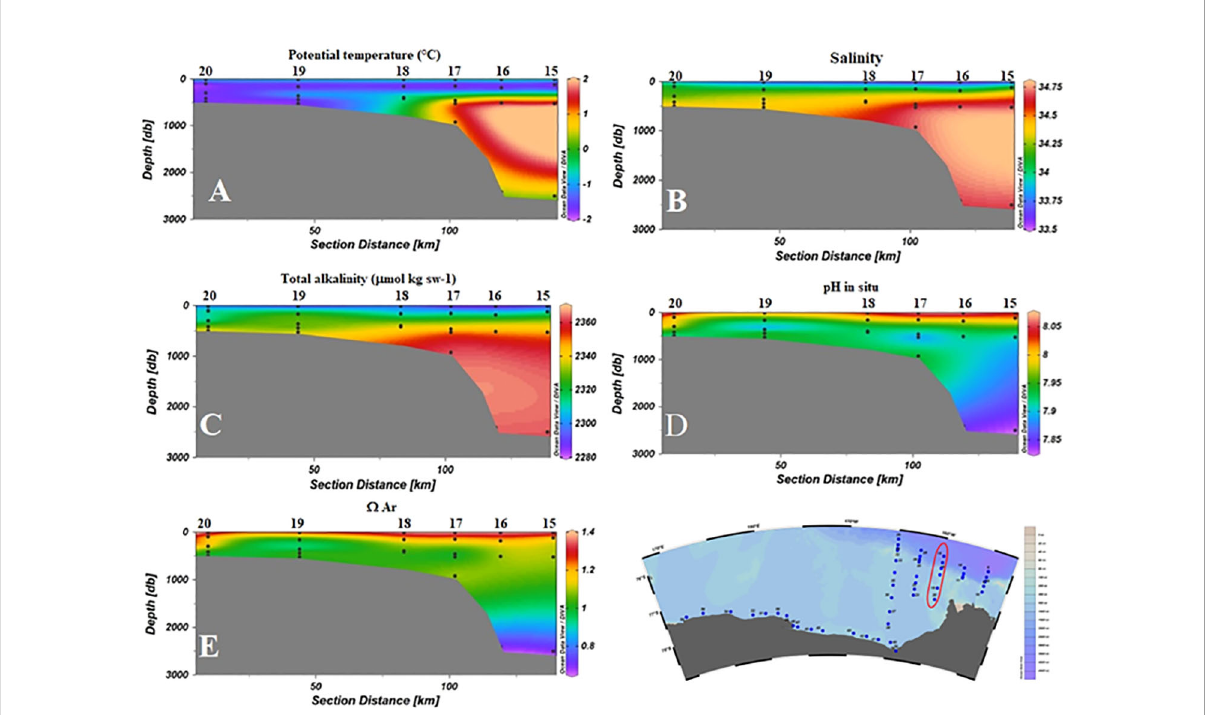
FIGURE 8 Distribution of physical and chemical parameters as a function of depth for S3 (stations 15 – 20). (A) Potential temperature (°C); (B) Salinity; (C) A T (µmol kg sw -1 ); (D) pH in situ ; (E) W